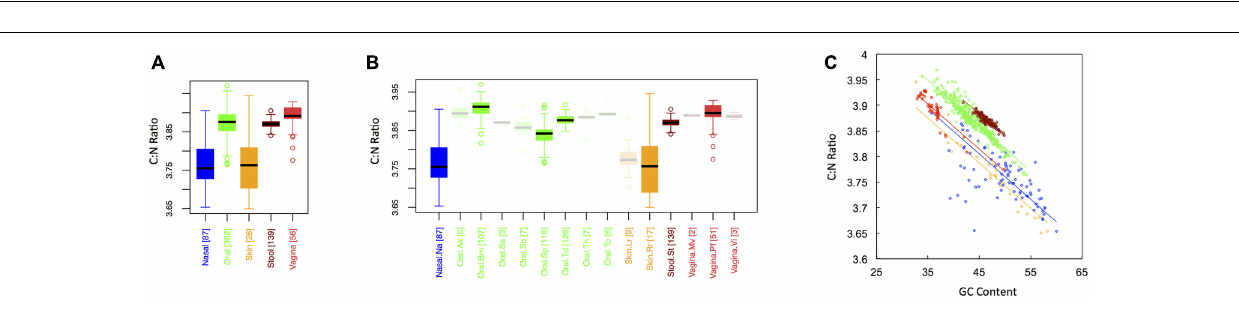
FIGURE 5 | Boxplots showing the average C:N ratio of microbial proteins as a function of human body site for (A) the 5 major sites and (B) the 15 minor sites in our study. The number of samples from each site is indicated in square brackets on axis labels. Faded boxes are used for sites with fewer than 10 samples. Differences in C:N ratio were tested with Dunn’s test. Statistics are summarized in Appendix II, Tables A.2.13, A.2.14; (C) Scatterplot of C:N ratio versus GC content with associated regression lines from our ANCOVA analysis for major body sites: nasal (blue), oral (green), skin (yellow), stool (brown), and vaginal